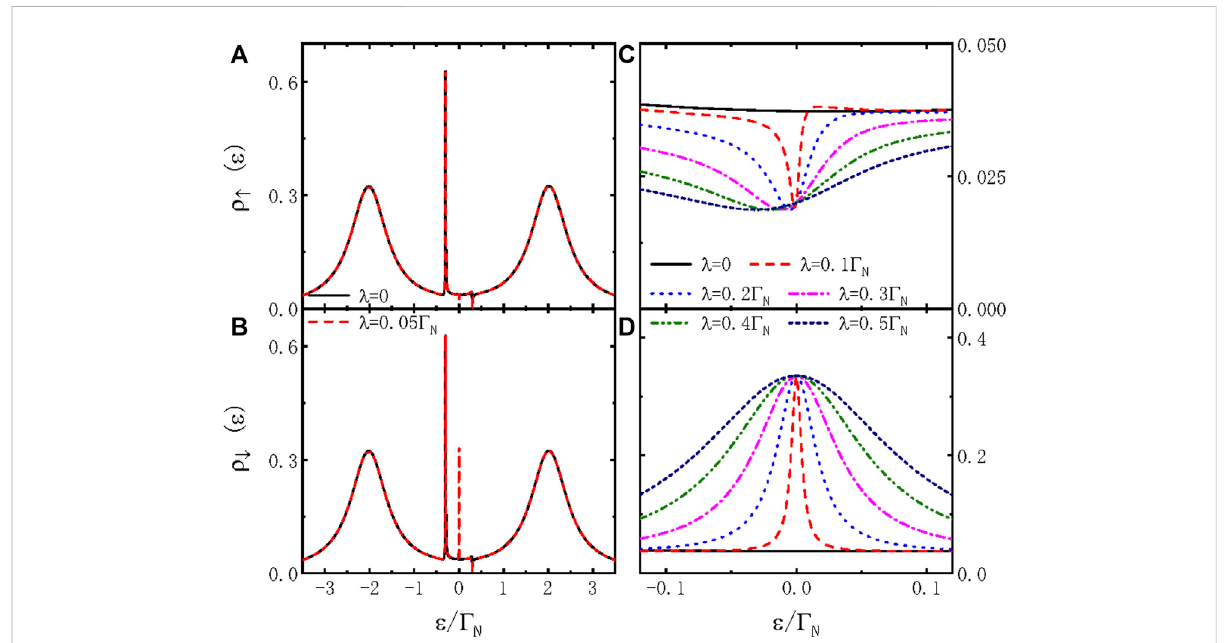
FIGURE 1 (Color online) Spin-dependent LDOS ρ σ varying with respect to the electron energy ε for different values of dot-MZM hybridization strength λ . Thetunnelingstrength betweenthecentral dotand theside-coupled dot is fi xedas t c =0.2 Γ N .The energylevels ofthetwodotsare ε d 1 =0and ε d 2 = 0.3 Γ N , respectively. Direct hybridization between the MZMs is ε M =